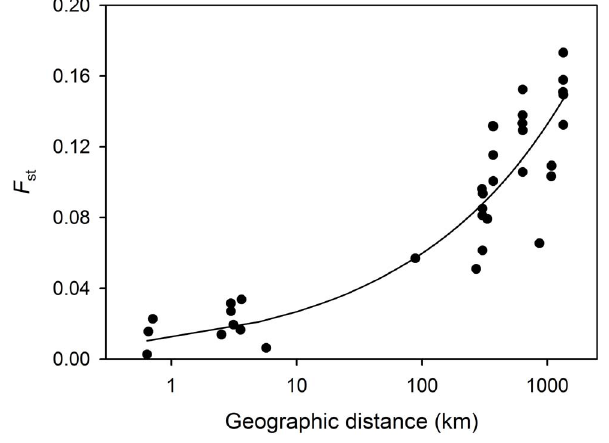
Figure 2. The relationship between geographic and genetic distance ( F st) among nine M.antarctica populations. To indicate the underlying trend, a power regression was fitted (y=0.0121 6 0.3467 , r 2 =0.811), which explains a marginally greater proportion of the variance than logarithmic or second order polynomial regressions ( r 2 =0.777 and 0.782